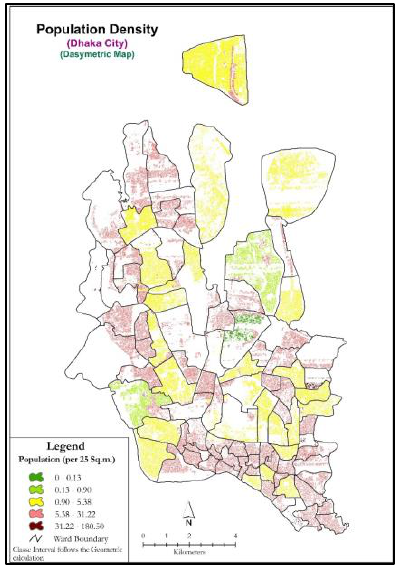
Figure 7. Output of the 5 × 5 m raster-based dasymetric mapping of the study area.